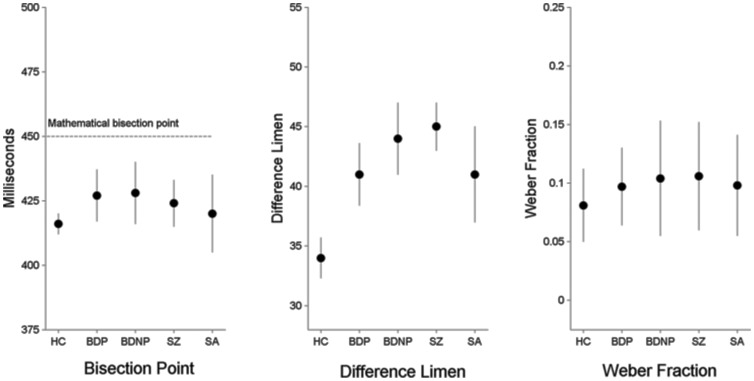
Means and standard deviations for each group for the bisection point (left panel), difference limen, (center panel) and Weber Fraction (right panel).No differences existed between groups on bisection point, although for all groups the perceived bisection point occurred earlier than the mathematical bisection point. SZ, BDP, and BDNP had increased temporal variability on both the difference limen and the Weber Fraction compared to controls. The SA group was not significantly different from controls.